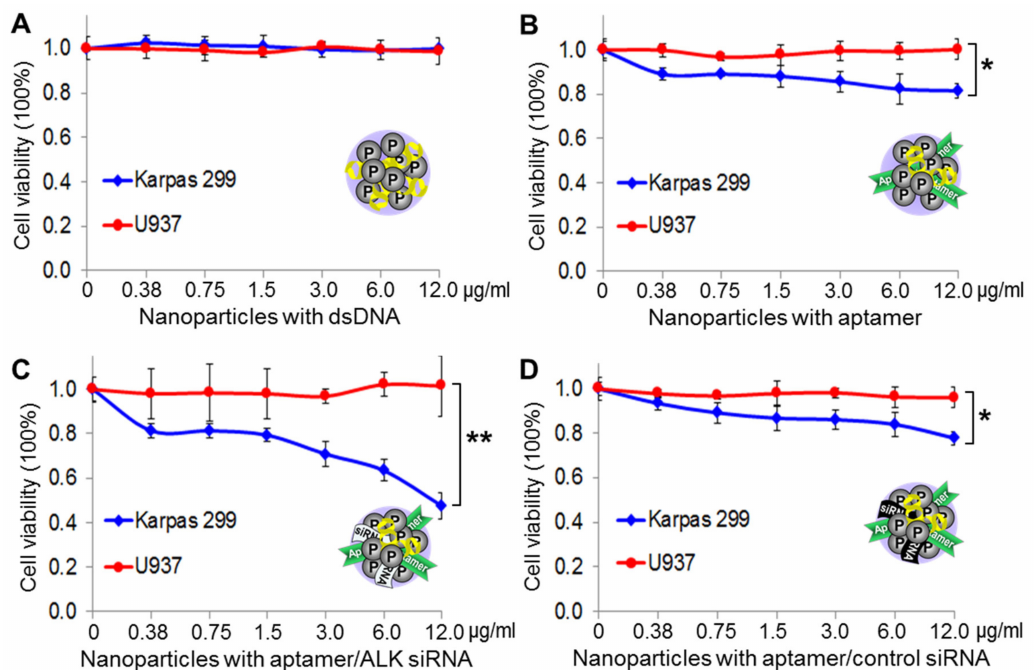
Figure 6. Cellular e ff ects of protamine nanoparticles. Lymphoma cells were exposed to a series of protamine nanoparticles, as indicated. Cell viability was then evaluated by counting viable cells using the trypan blue exclusion method three days post-treatment. ( A ) Protamine nanoparticles composed of dsDNA alone had no e ff ect on the viability of Karpas 299 or U937 cells. ( B ) Protamine nanoparticles composed of CD30 aptamers caused 19% decrease in viability of Karpas 299 cells, but no e ff ect on U937 cells. ( C ) Protamine nanoparticles composed of the aptamer and siRNA specific for ALK oncogene caused death in 53% of Karpas 299 cells, but had no e ff ect on o ff -target U937 cells. ( D ) In contrast, protamine nanoparticles composed of aptamers and a non-relevant control siRNA had no additional e ff ect on Karpas 299 cells, compared to (B). The data shown represent mean ± SD, n = 3 independent experiments; * p < 0.05, ** p <